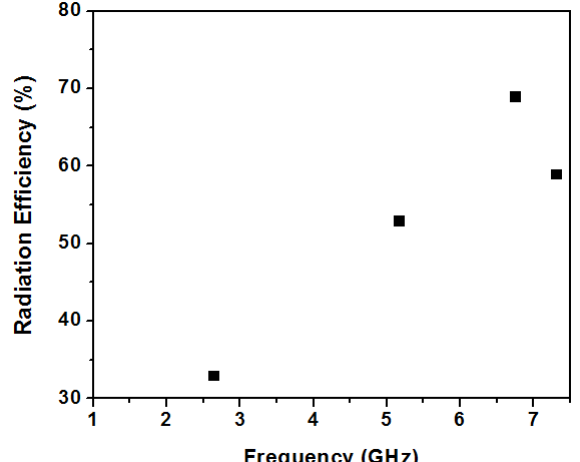
Figure 13. Radiation Efficiency of the proposed